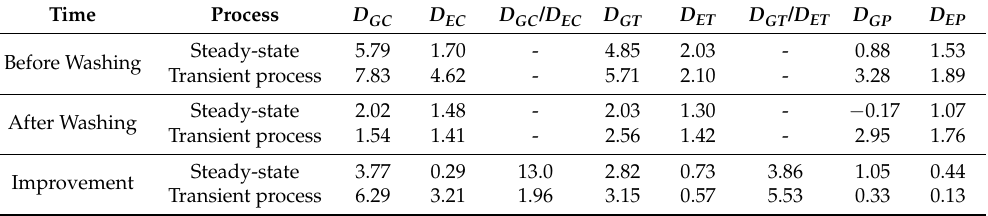
Table 3. Comparison result of diagnostic results based on steady-state analysis and transient process analysis (%). Time Process D GC D EC D GC /D EC D GT D ET D GT /D ET D GP D EP Steady-state Before Washing Steady-state After Washing